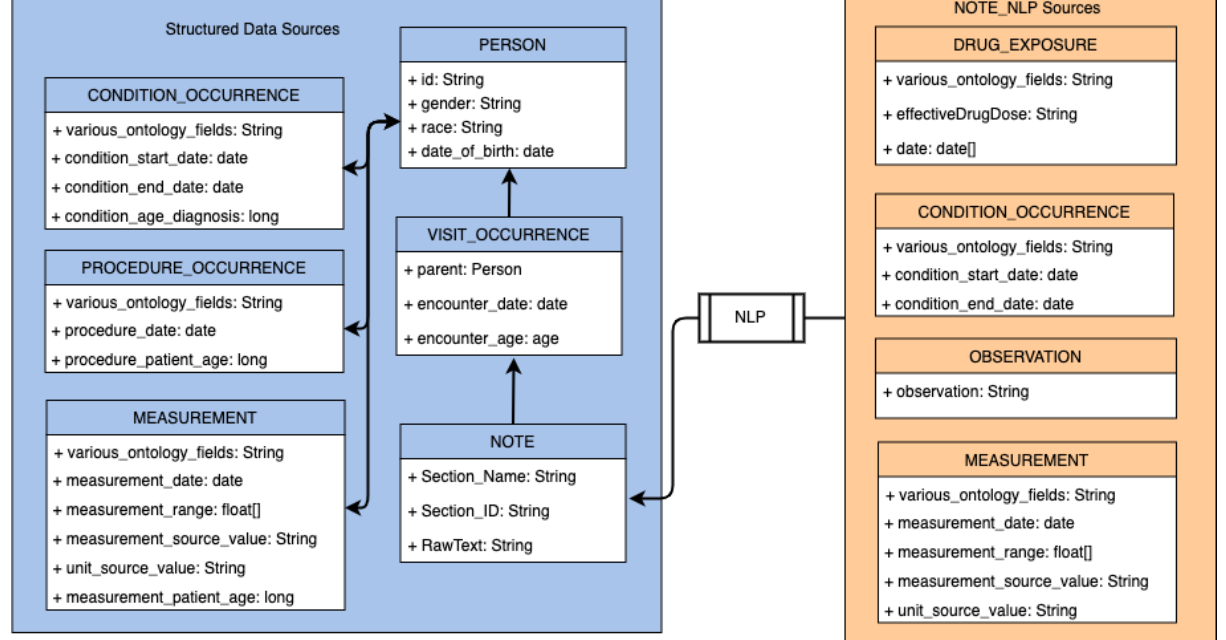
Figure 2. Hierarchical index structure using the OMOP Common Data Model. NLP: natural language